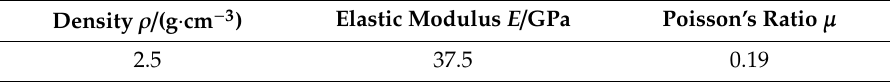
Table 5. Mechanical parameters of reinforced concrete materials.